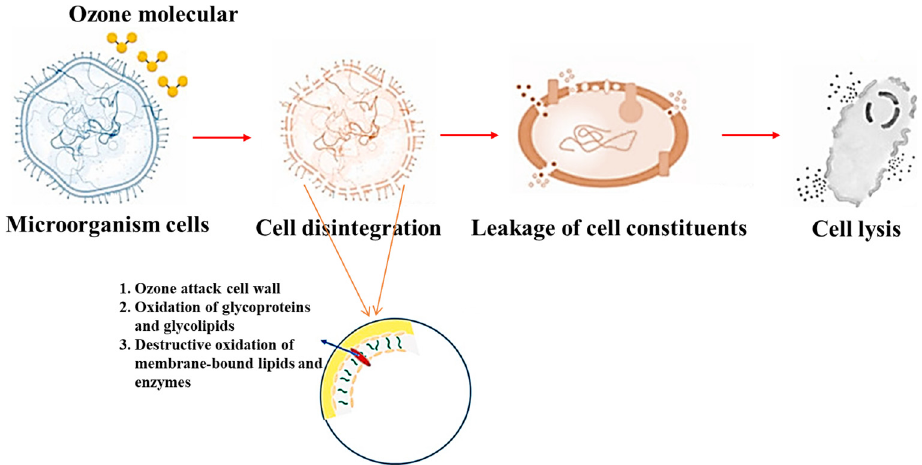
Figure 1. Schematic diagram of microbial inactivation by ozone treatment.